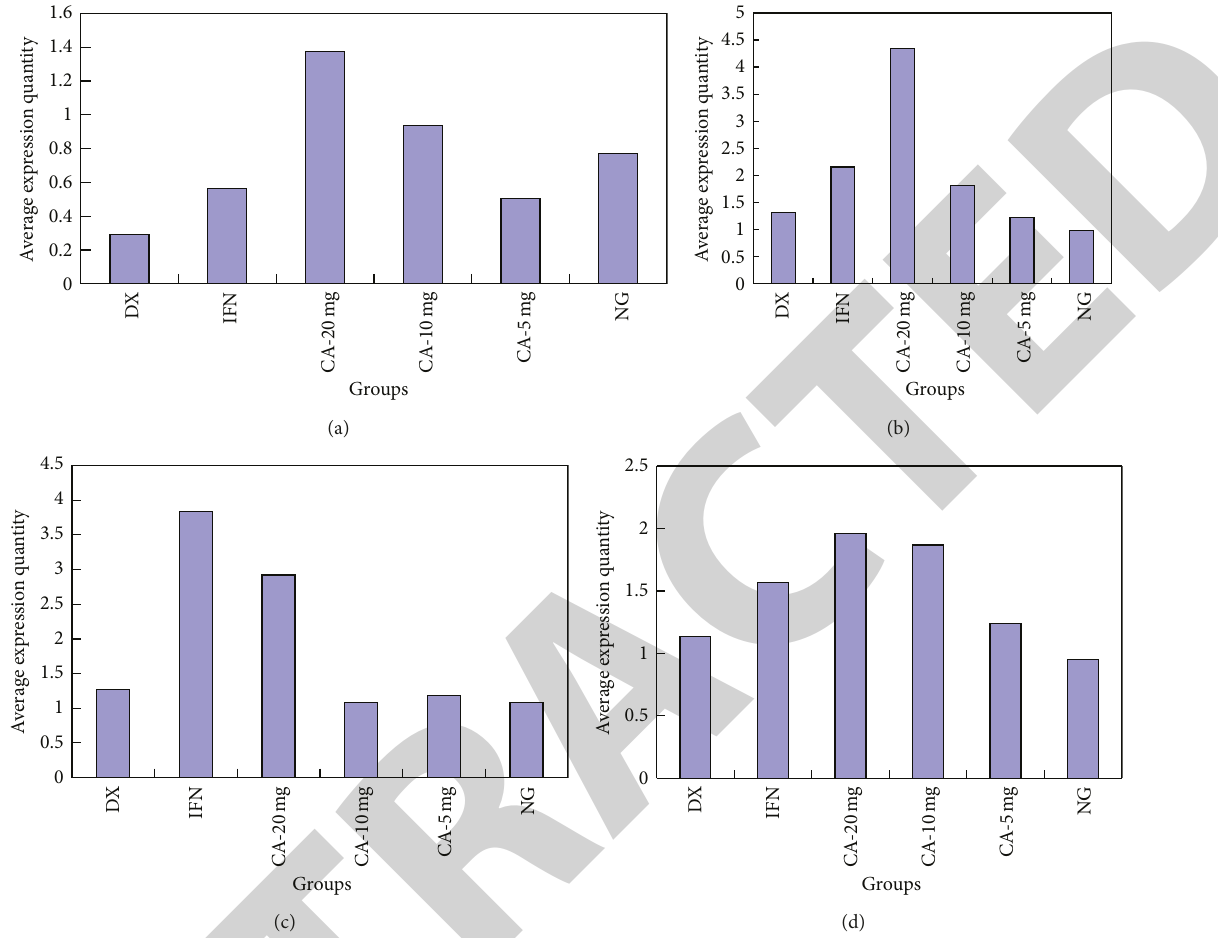
Figure 2: Relative expressing quantity of Nfatc2ip, Nfatc3, Nfatc2, and CaN in each groups. (a) Comparsion of Nfatc2ip expressing quantity among every group. (b) Comparsion of Nfatc3 expressing quantity among every group. (c) Comparsion of Nfatc2 expressing quantity among every group. (d) Comparsion of CaN expressing quantity among every groups.